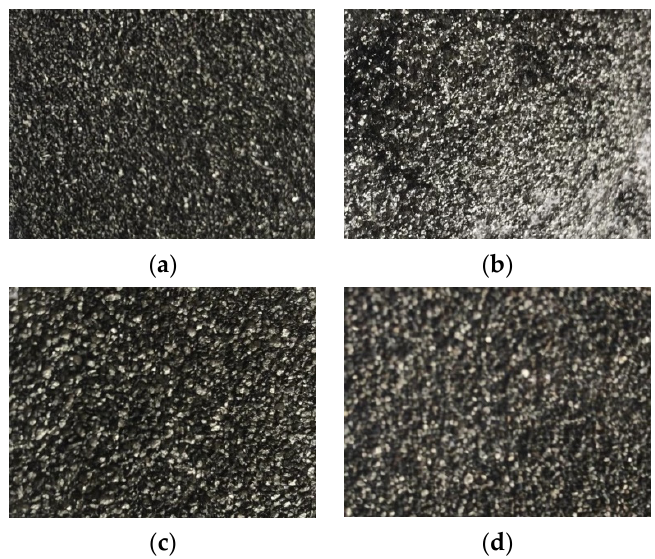
Figure 3. Four types of graphite with different purity. ( a ) High-purity graphite; ( b ) High-carbon graphite; ( c ) Medium-carbon graphite; ( d ) Low-carbon graphite.